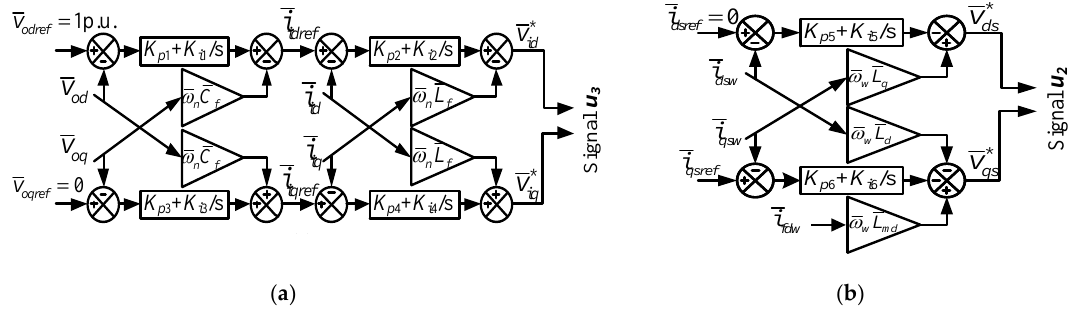
Figure 5. Control loops of the converters: ( a ) Controllers of the load-side converter; ( b ) Controllers of the generator-side converter.